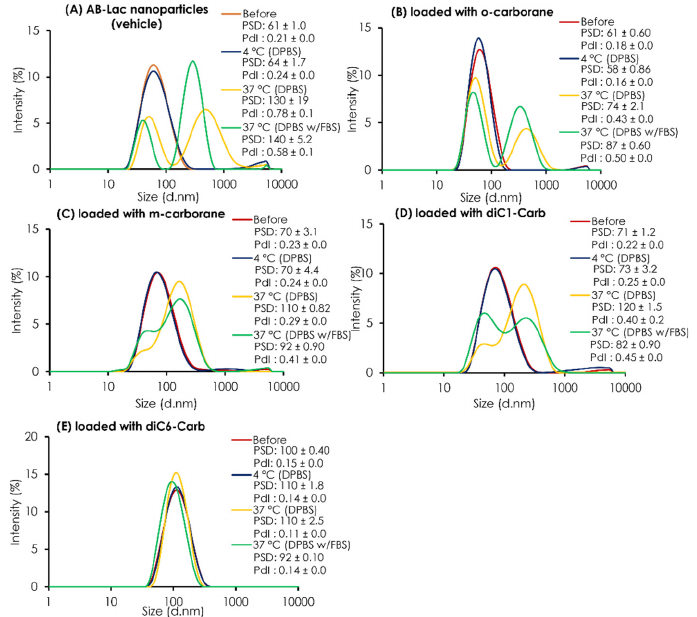
Figure 3. The stability test of AB-Lac particles loaded with B compounds. The PSD and PdI inside a dialysis bag before and after 24 h dialysis. The AB-Lac particles (vehicle) ( A ), loaded with o- carborane ( B ), with m- carborane ( C ), with diC1-Carb ( D ), and with diC6-Carb ( E ) against DPBS at 4 °C and either against DPBS or DPBS with 10% FBS at 37 °C were calculated. The PSD and PdI are represented as mean ± S.D. ( n = 3).